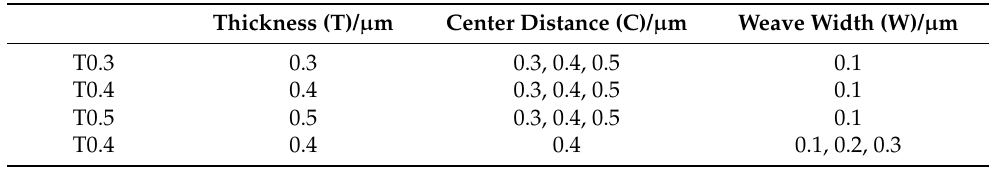
Figure 1. Schematic diagram of the test setup: (1) rotary motor, (2) sample table, (3) block specimen, (4) ball specimen, (5) ball holder, (6) suspension, (7) 2-D strain-gauge force sensor, (8) computer. Table 2. The weaving parameters of samples.